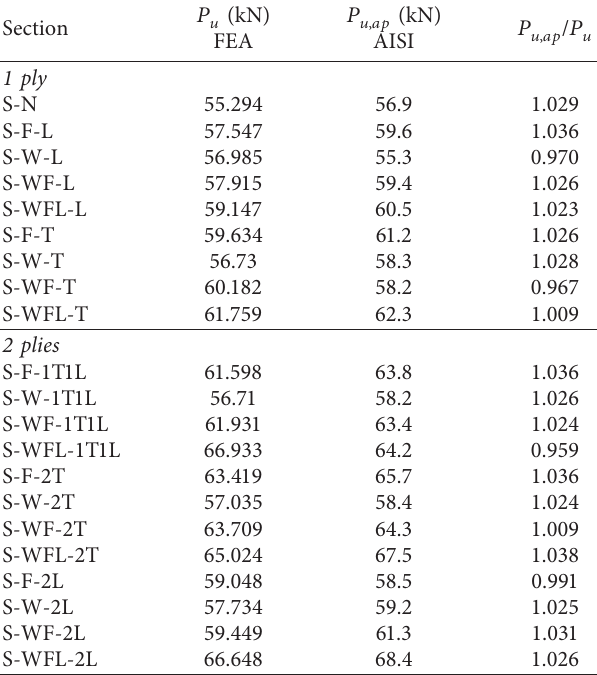
Table 10: Short column ultimate load estimates, for 1, 2 CFRPS.